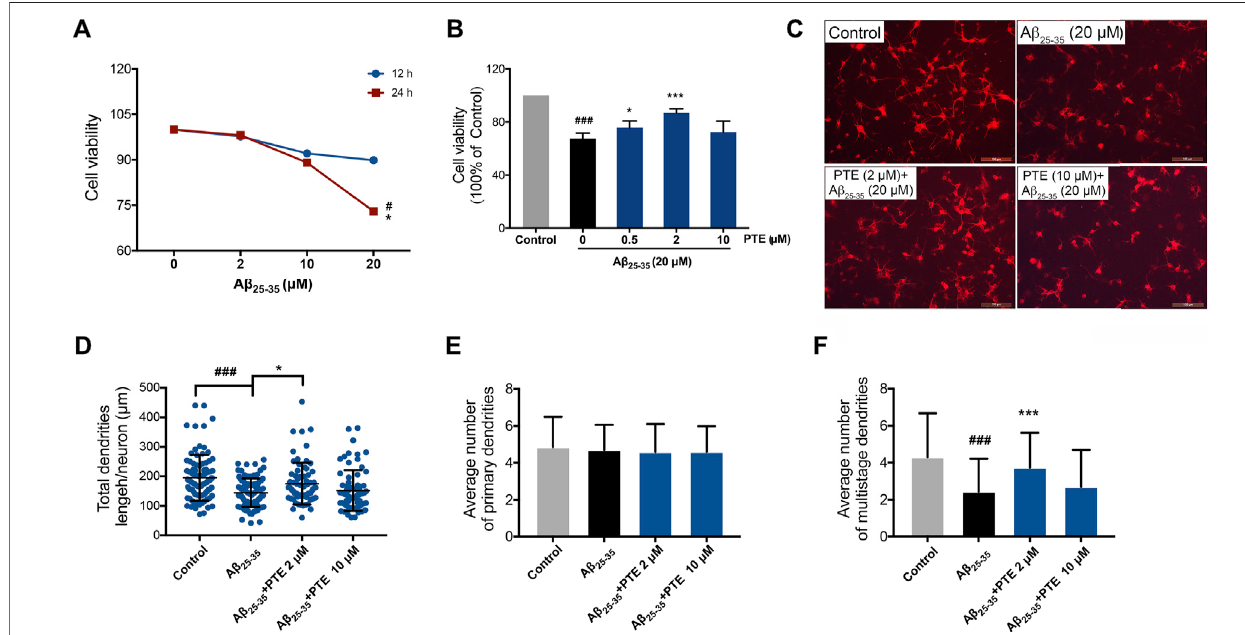
FIGURE 7 | Effects of PTE on A β 25-35 -induced neuronal and mitochondrial injury. (A) Cell viability of A β 25-35 on neurons was determined by CCK-8 assay. # p < 0.05 vs neurons treated without A β 25-35 ; * p < 0.05 vs neurons treated with 2 μ M A β 25-35 for 24 h. (B) Cell viability determination of A β 25-35 -induced neurons after treatmentwithPTE. (C) NeuronalmorphologyofdendriteswasdeterminedwithMAP-2immuno fl uorescence(70 – 90corticalneuronspergroupwerecalculated). (D – F) Quanti fi cationsofthetotaldendriticlength (D) ,theaveragenumberofprimarydendrites (E) ,andmultistagedendritesperneuron (F) .Dataareshownasmean±SD (n = 3). ### p < 0.001 vs control; * p < 0.05, *** p < 0.001 vs A β 25-35